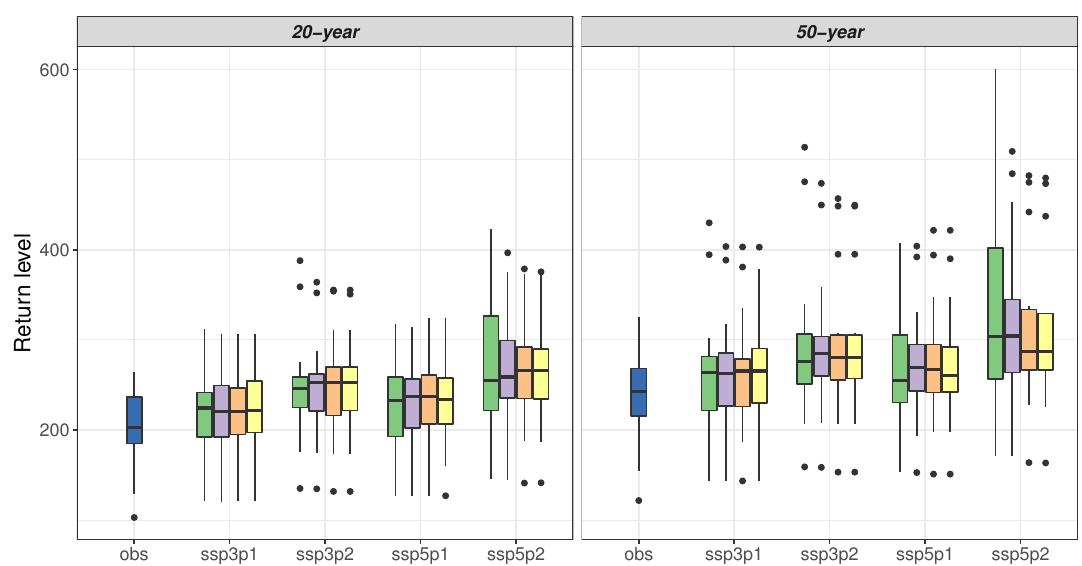
Figure 8. Schematic box-plots of 20- and 50-year return levels of the annual maximum daily precipitation for 15 grid cells over the Korean peninsula obtained from various α -weighting methods based on Bayesian model averaging (BMA), the chi-square statistic (chisq), the continuous rank probability score ( crps ), and the simple averaging (sa) for the future periods P1 (2021–2060) and P2 (2061–2100) under the SSP3 and SSP5